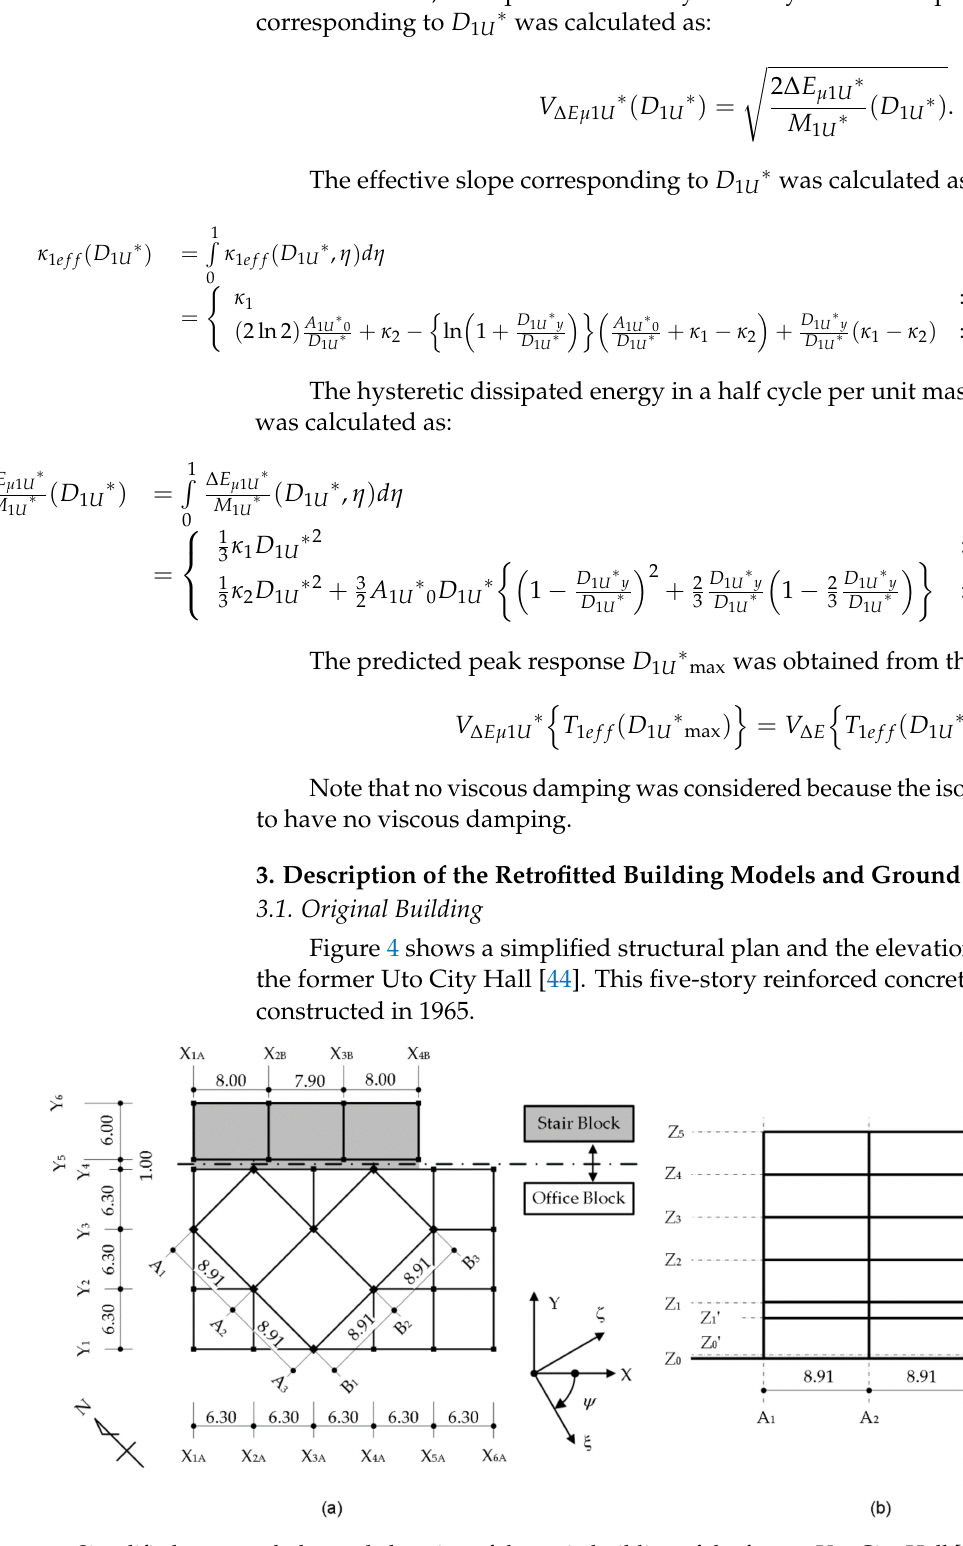
Figure 4. Simplified structural plan and elevation of the main building of the former Uto City Hall [44]: ( a ) Structural plan (Level Z 0 ) and ( b ) simplified plan elevation (frame B 1